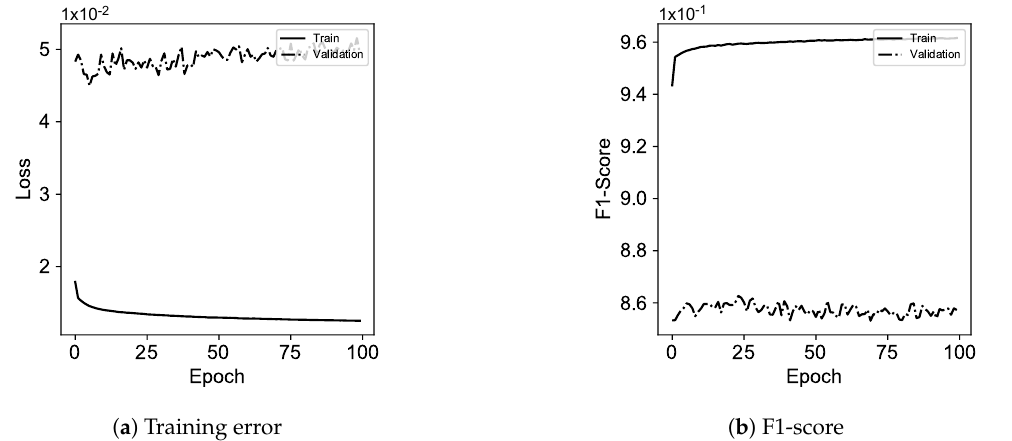
Figure 13. The loss and F1-score over 100 epochs for the recommender.